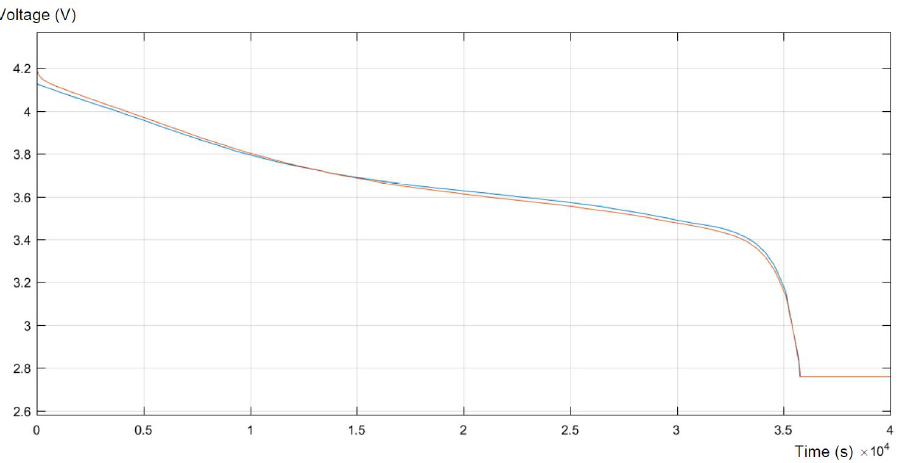
Figure 6. Comparison between the model and NMC1 during the discharge process performed with 0.1 C. The blue curve is the real discharge process measured on the workstation. The red curve presents the model response in the same